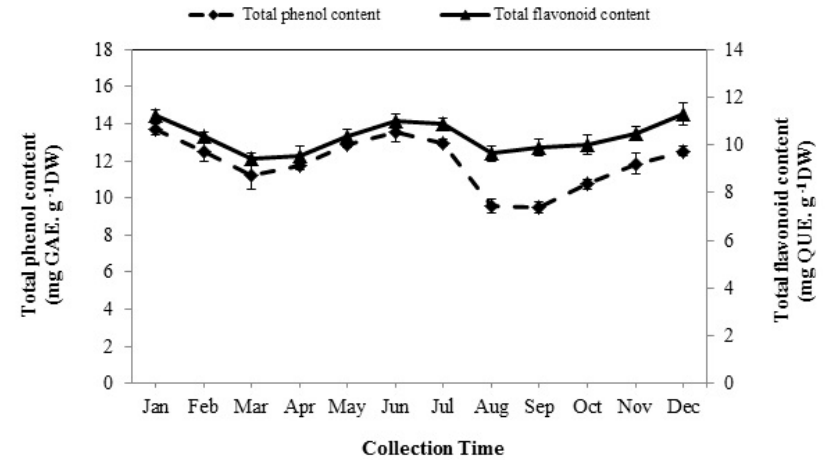
Figure 2. The seasonal variation of total phenol and flavonoid contents of Arabian lilac. Values are the mean ± SD of three replications ( n = 3). DW: dry weight; GAE: gallic acid equivalents.